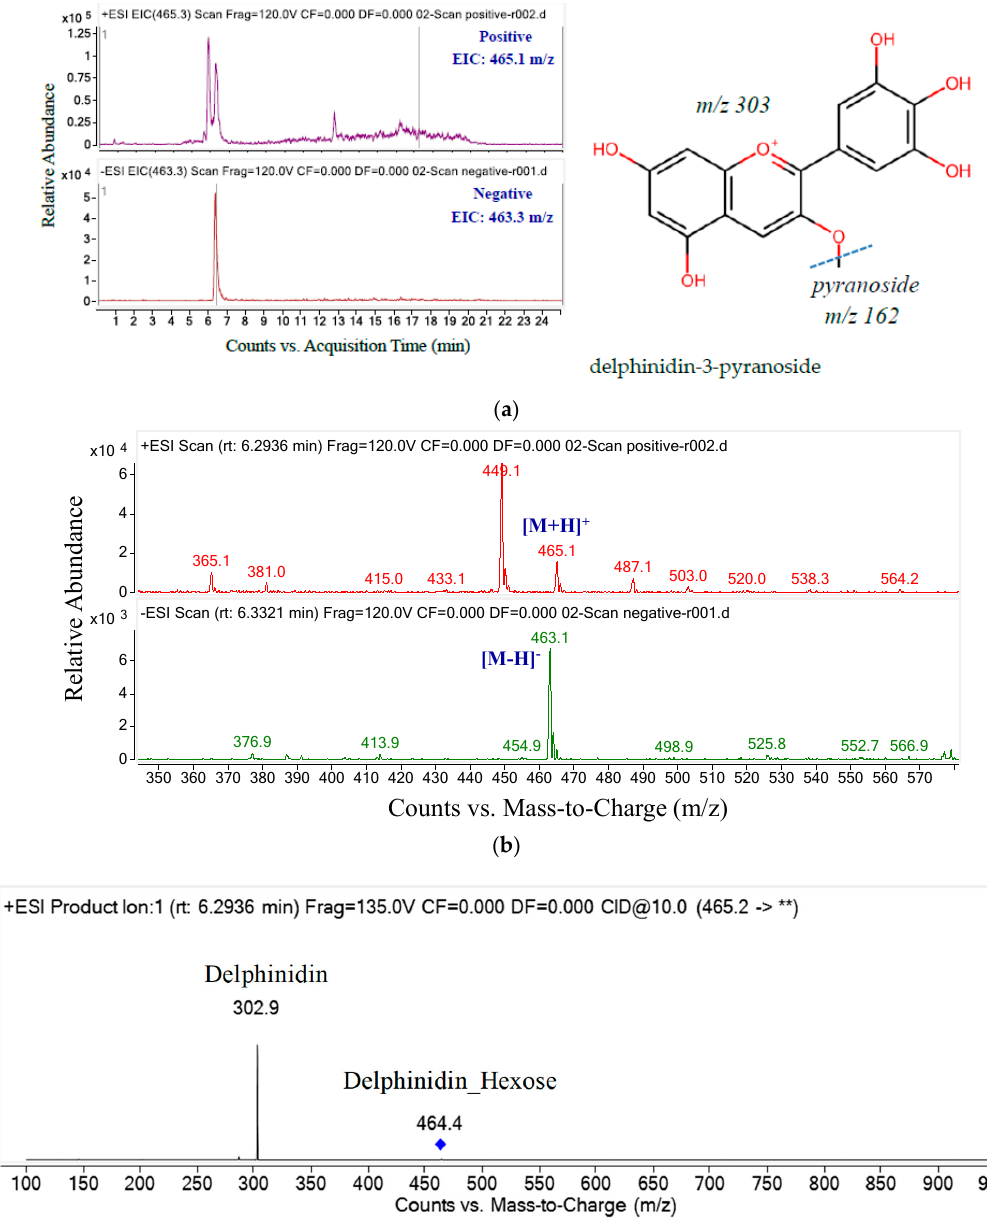
Figure 7. The ion chromatograms ( a ) and ion spectra ( b ) and MS/MS fragments (**) of parent mass 465.2 ( c ).